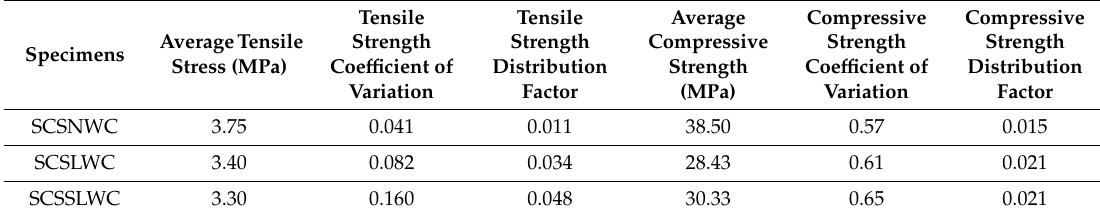
Table 2. The concrete strength of the mixes.